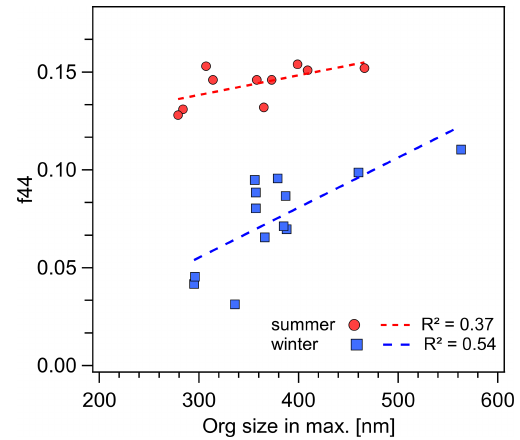
Figure 6. Relationship between the organic fragment f 44 and the size of the organic fraction during episodes of high NR-PM 1 species mass concentrations in both